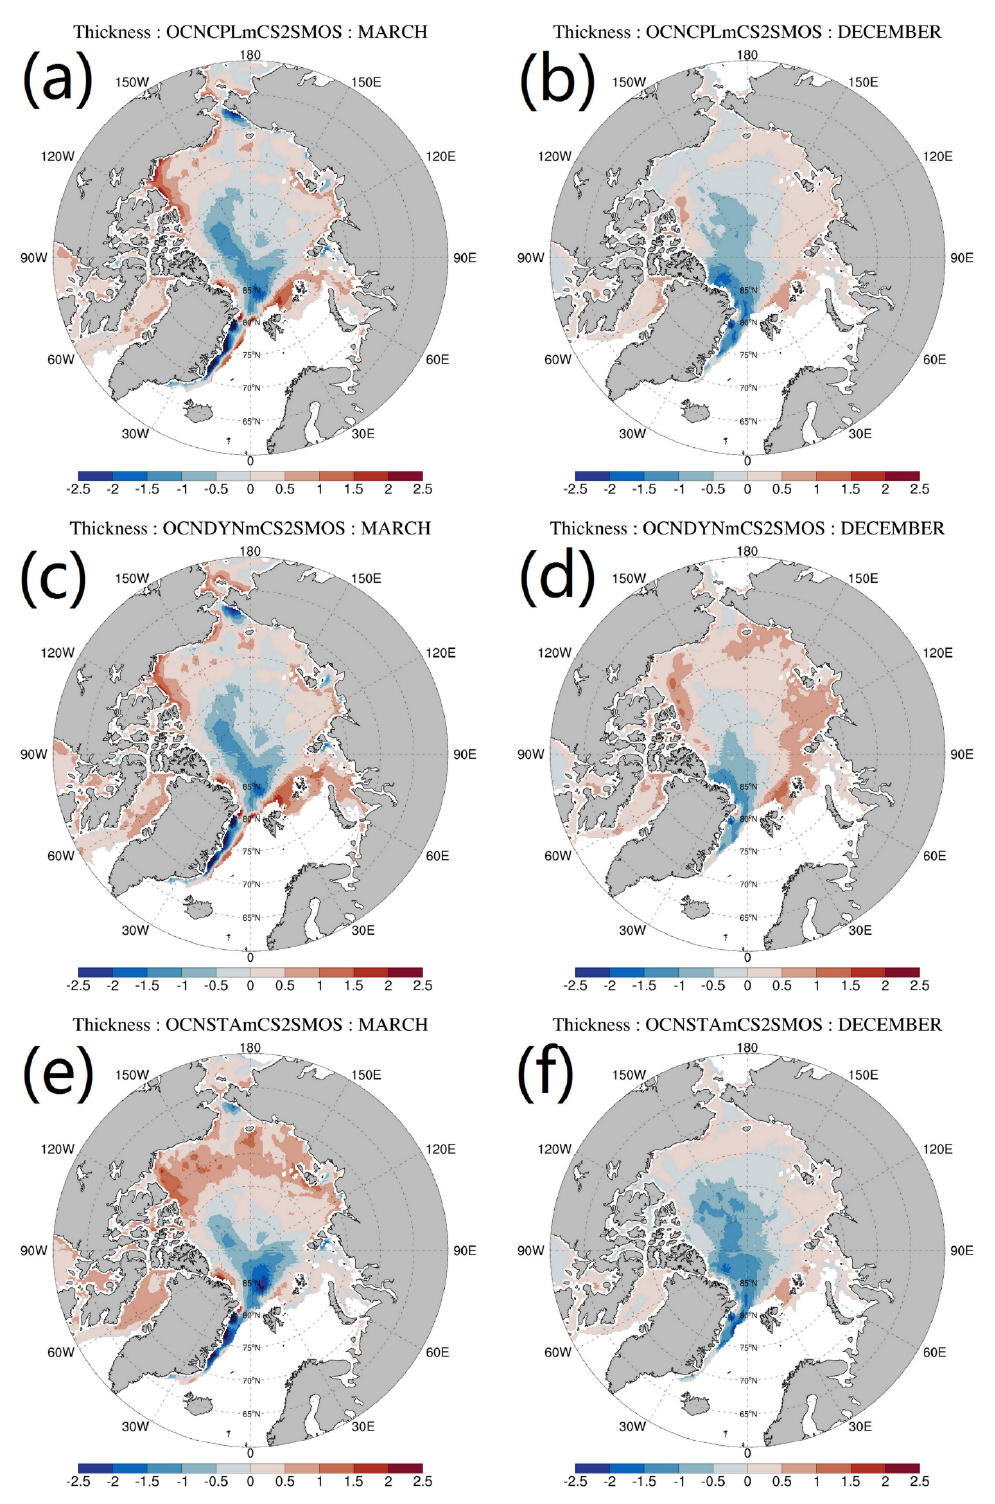
Figure 12. Deviation of the modeled monthly mean sea ice thickness and the CS2SMOS data. The top, middle and bottom panels show sea ice thickness deviation of the OCNCPL run, the OCNDYN run and the OCNSTA run, respectively. The left and right panels show results in March and